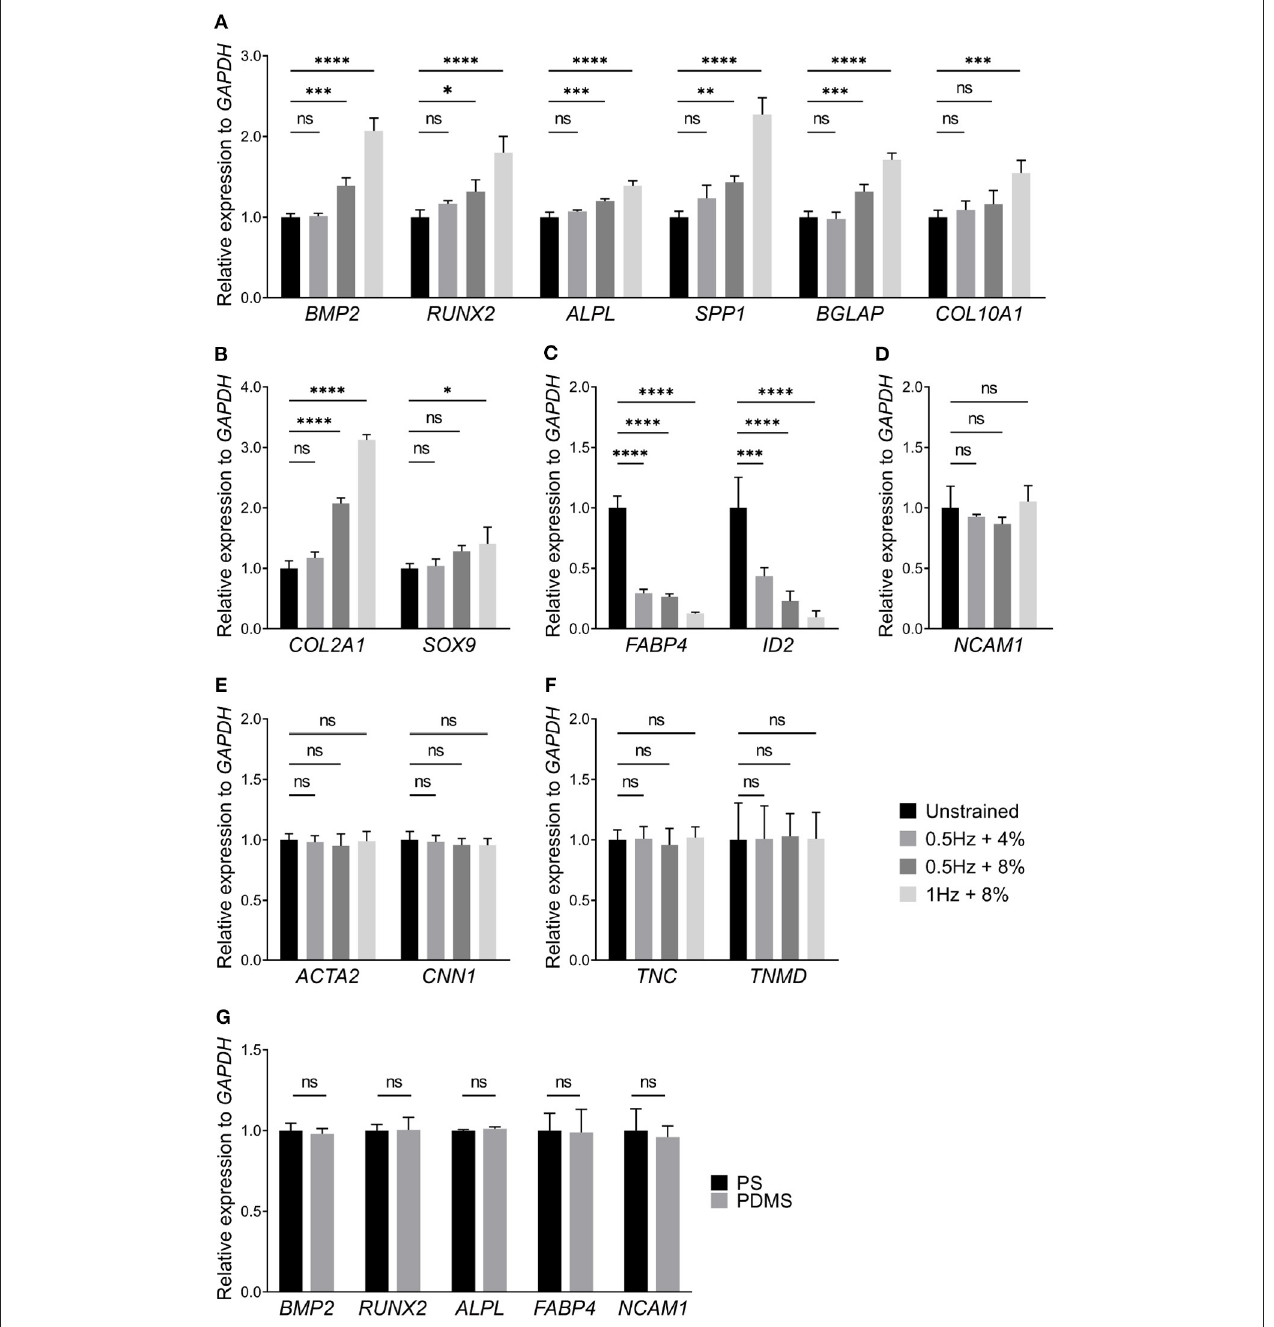
FIGURE 4 | Relative expression levels of (A) osteogenic, (B) chondrogenic, (C) adipogenic, (D) neurogenic, (E) myogenic, and (F) tenogenic marker genes of hMSCs subjected to UCS for 48 h were shown above, respectively. The application of 1 Hz at 8% stretch significantly increased the expression of osteogenic (A) and chondrogenic (B) marker genes. However, the expression of adipogenic marker genes, FABP4 and ID2, were decreased at three kinds of UCS groups (C) . The expression of osteogenic and chondrogenic marker genes between unstrained and 0.5 Hz + 4% strain group showed no change. There were no significant changes in relative expression of genes associated with neurogenesis, myogenesis, and tenogenesis between different mechanical groups (D–F) . (G) Relative expression of several differentiation marker genes of hMSCs cultured on polystyrene (PS) culture dishes and PDMS chambers for 48 h. No significant changes were found in relative expression of marker genes between PS and PDMS substrates. Significant differences were noted by * P < 0.05, ** P < 0.01, *** P < 0.001, and **** P < 0.0001. ns signifies P > 0.05. n = 4.